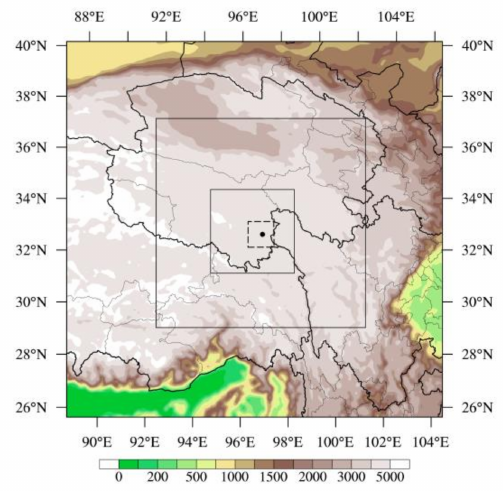
Figure 2. The model domain and topography (unit: m). The first nested area contains most of the TP area, the second nested area is located in the eastern part of the TP, and the third nested area focuses on the concentration of observation sites in the eastern part of Yushu Tibetan Autonomous Prefecture in southern Qinghai Province. The area average of the black dashed area in the figure is used for comparison with the radar